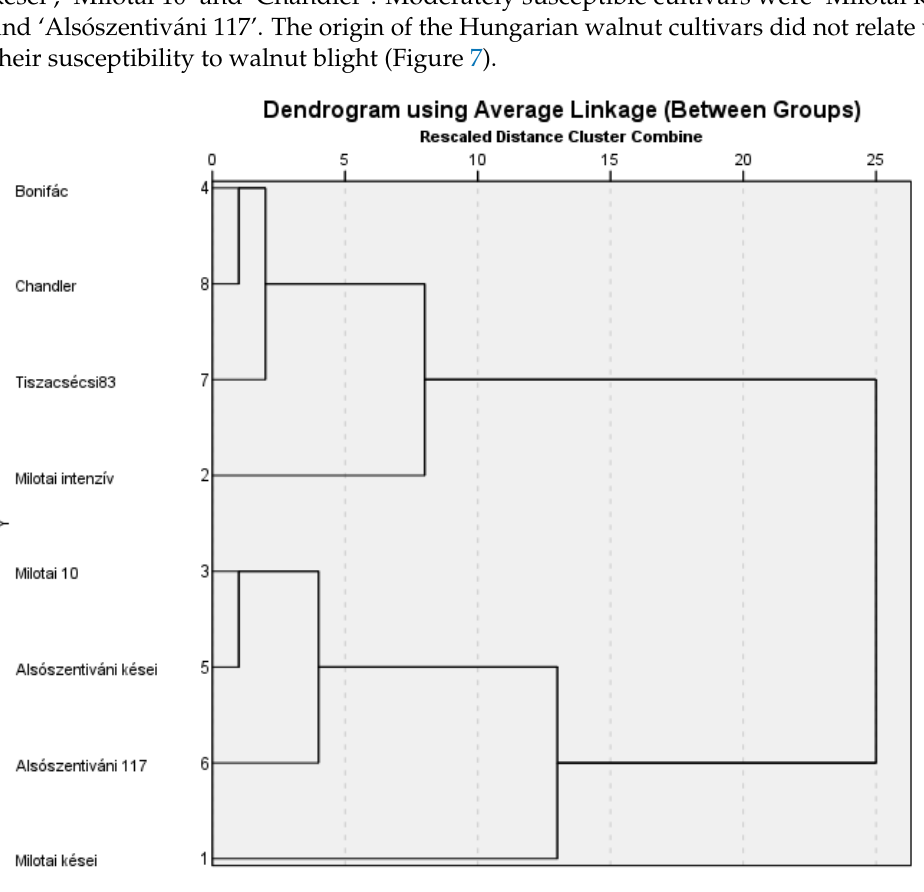
Figure 7. Dendrogram of Hungarian-bred walnut cultivars from the point of view of their susceptibility to walnut blight.